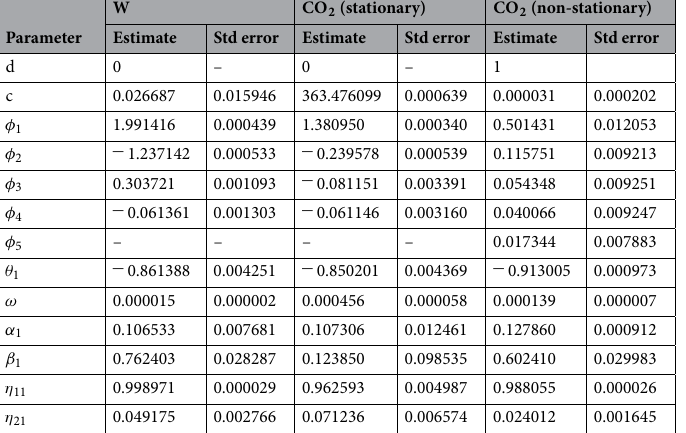
Table 2. ARIMA-CGARCH model parameters estimated for vertical wind speed ( w ) and two time series of carbon dioxide concentration (CO 2